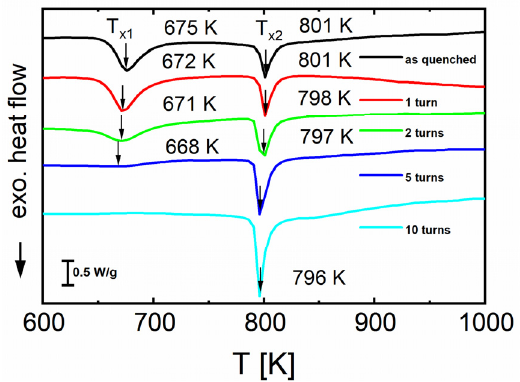
Figure 10. Constant-rate heating DSC scans (heating rate 20 K/min) of alloy B (Fe 81.2 Co 4 Si 0.5 B 9.5 P 4 Cu 0.8 ) before (as-quenched) and after HPT deformation at N = 1, 2, 5, and 10.